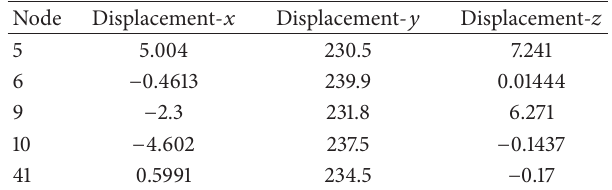
Table 5: The displacements (in m) at green nodes using the linear FEM for the third experiment. The displacements at blue nodes are zero.